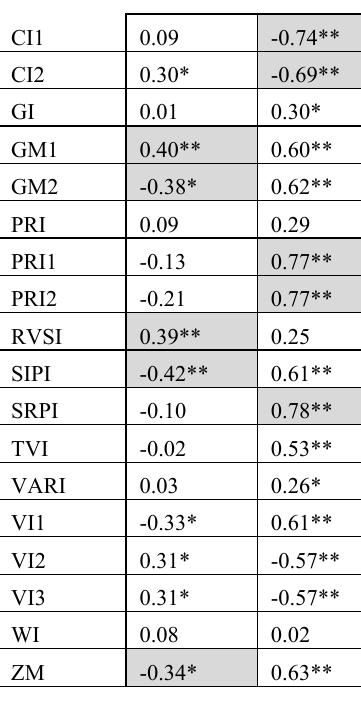
Table-2 Correlation coefficient between narrow band indices and bio physical parameters